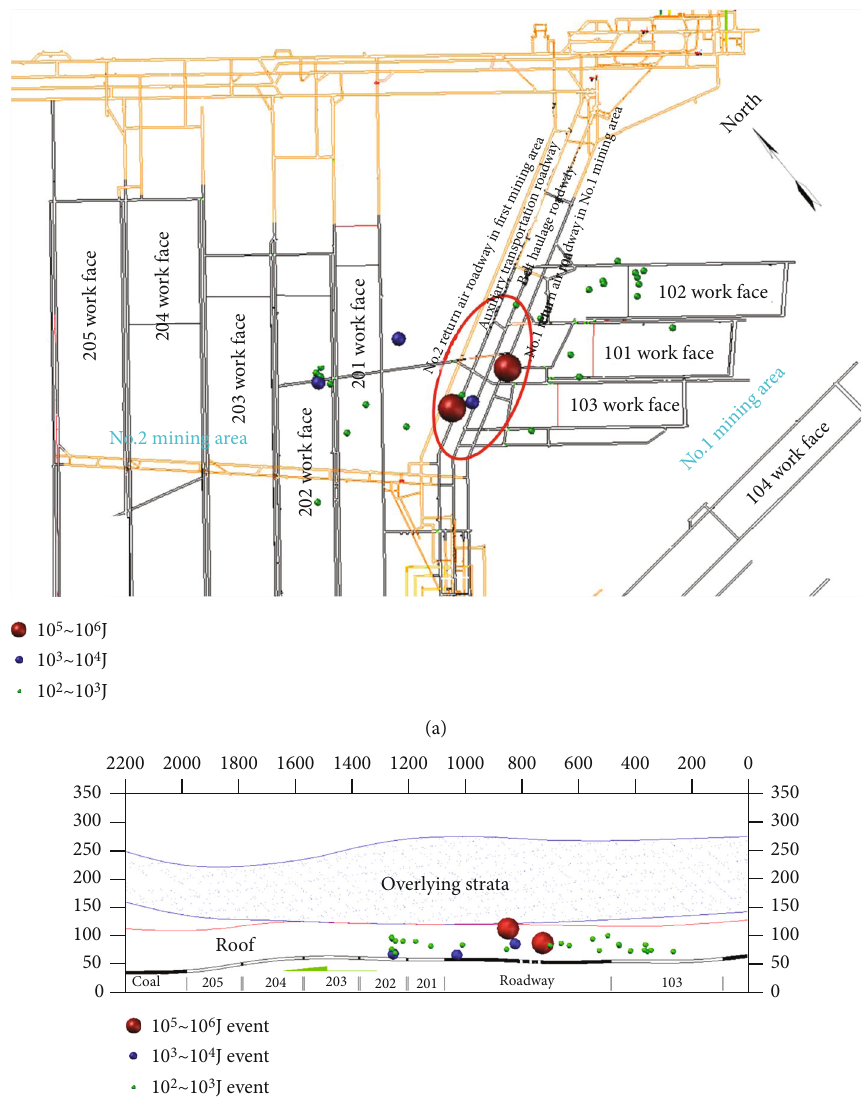
Figure 3: Location distribution of mine earthquake sources monitored by microseism. (a) Plane distribution of mine earthquake; (b) pro fi le distribution of mine